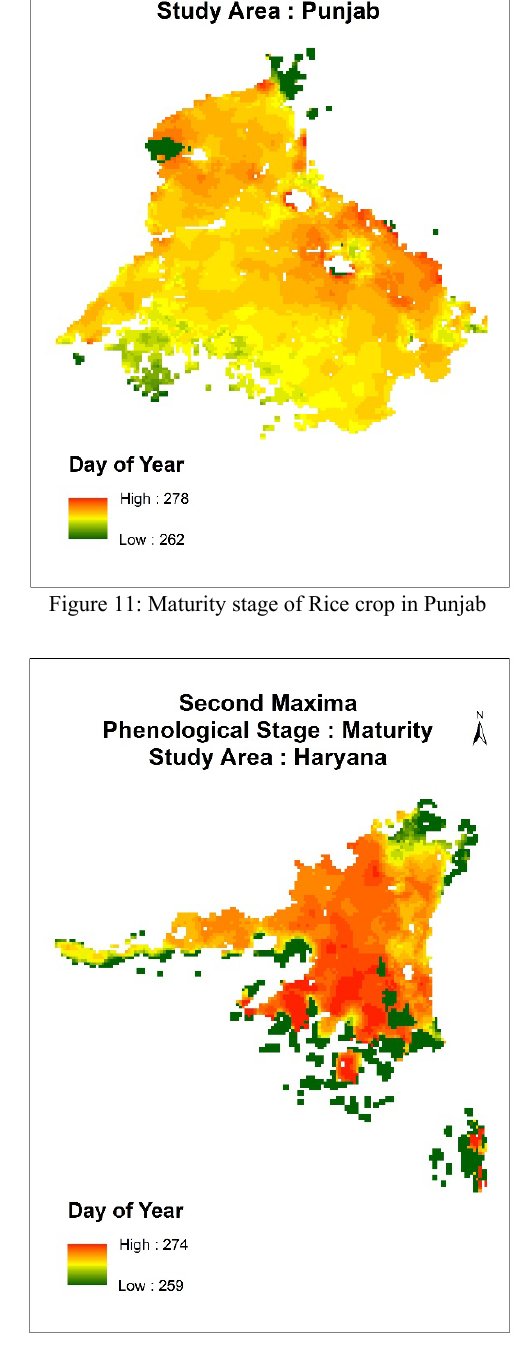
Figure 12: Maturity stage of Rice crop in